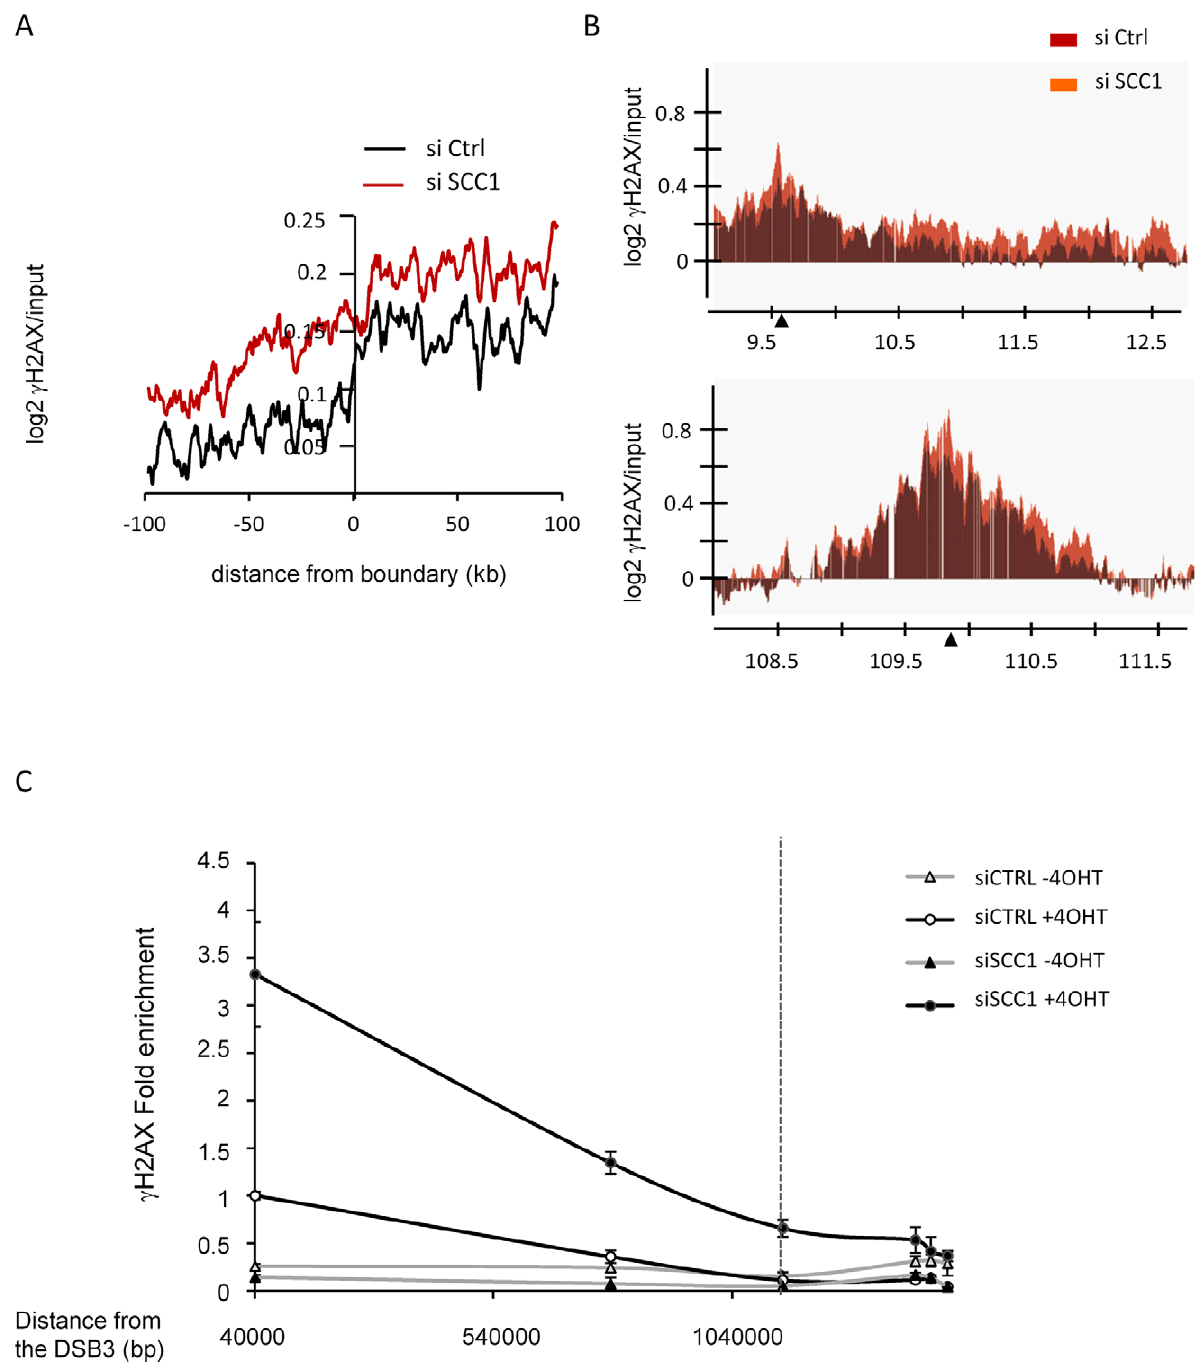
Figure 6. Involvement of cohesin at c H2AX domains boundaries. A, Boundaries of c H2AX domains (from the average of two 4OHT-induced c H2AX/input ChIP-chips) were determined in control cells using our previously described algorithm (see Table S2). Data were aligned and overlaid with the right and mirror left borders combined. Data are shown over a 200 kb window centered on boundaries and averaged using a 10 kb window size. Profiles are shown for c H2AX in control cells (black) and in SCC1 siRNA transfected cells (red). B, Detailed views of two c H2AX domains. The c H2AX profile from control cells (red) is presented with the c H2AX profile from SCC1 depleted cells (orange). Upper panel, the c H2AX signal, is able to spread further in SCC1 depleted cells. Lower panel, the c H2AX signal upon SCC1 depletion does not spread beyond the domain defined in control cells. Note that although both domains show different behaviors for c H2AX at the boundary, they both show a similar increase in c H2AX levels upon SCC1 depletion. C, c H2AX ChIP performed in 4OHT-treated control and SCC1 depleted cells were analyzed by Q-PCR, using primer pair located at various positions from the right boundary of the domain presented Figure 6B top panel. Data are expressed relative to the value obtained with the first primers pair (41 kb) in CTRL cells treated with 4OHT (set to 1). A representative experiment is shown. The position of the boundary identified in control cells by analyzing ChIP-chip with our algorithm is represented by a dotted line.